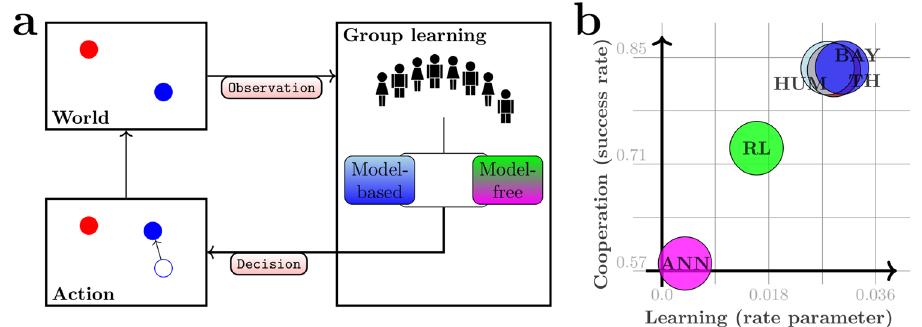
Figure 9. Results summary. a An overview of the key elements of the game. At every point in time the position of the target and the position of the cursor provoke a group decision that results in a cursor displacement on the screen. This movement is observed by the group and members of the group update their knowledge about the effect of their decisions and change their behaviour accordingly. To describe the human learning we compare four different models that can be categorized as either model-based (Bayes and Thompson) or model- free (Q-learning, Perceptron). ( b ) Sketch of the performance in terms of learning progress and cooperation of human learners and the four different models. The abscissa shows the rate parameter of an exponential distribution whose cumulative distribution function was fitted to the learning duration data shown in Fig. 6b and the ordinate shows the success rate as shown in Fig.